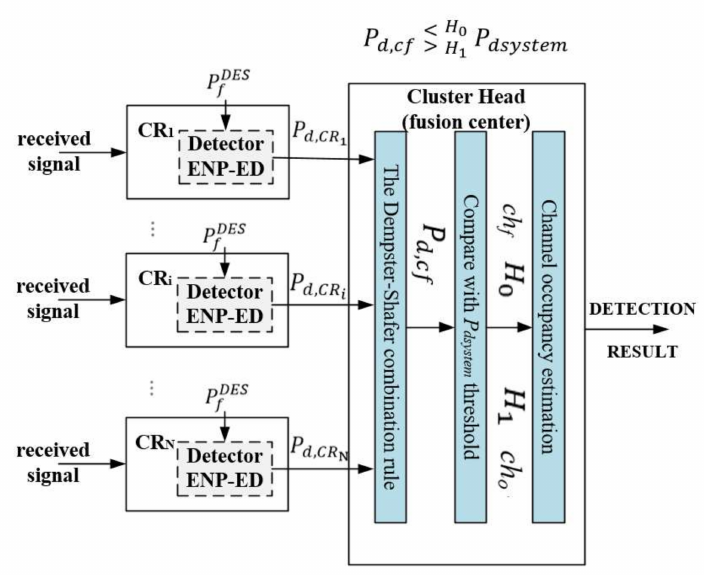
Figure 2. Scheme of distributed cooperative spectrum monitoring with data fusion